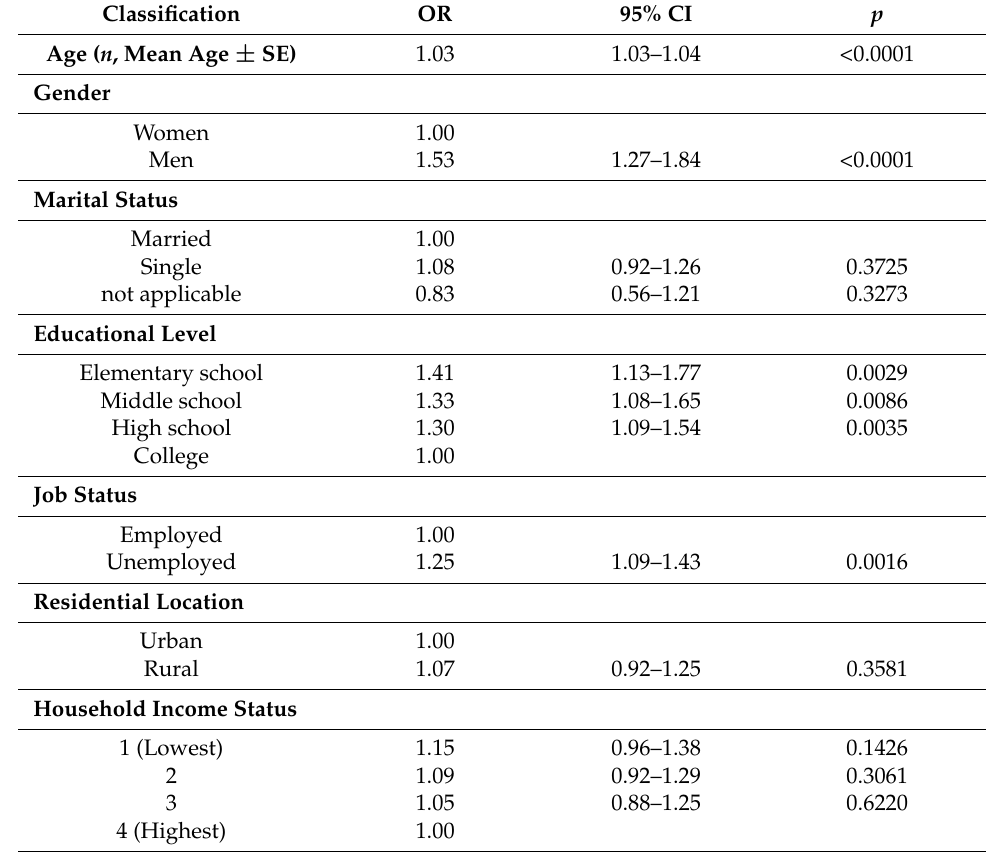
Table 2. Multivariate logistic regression on the prevalence of